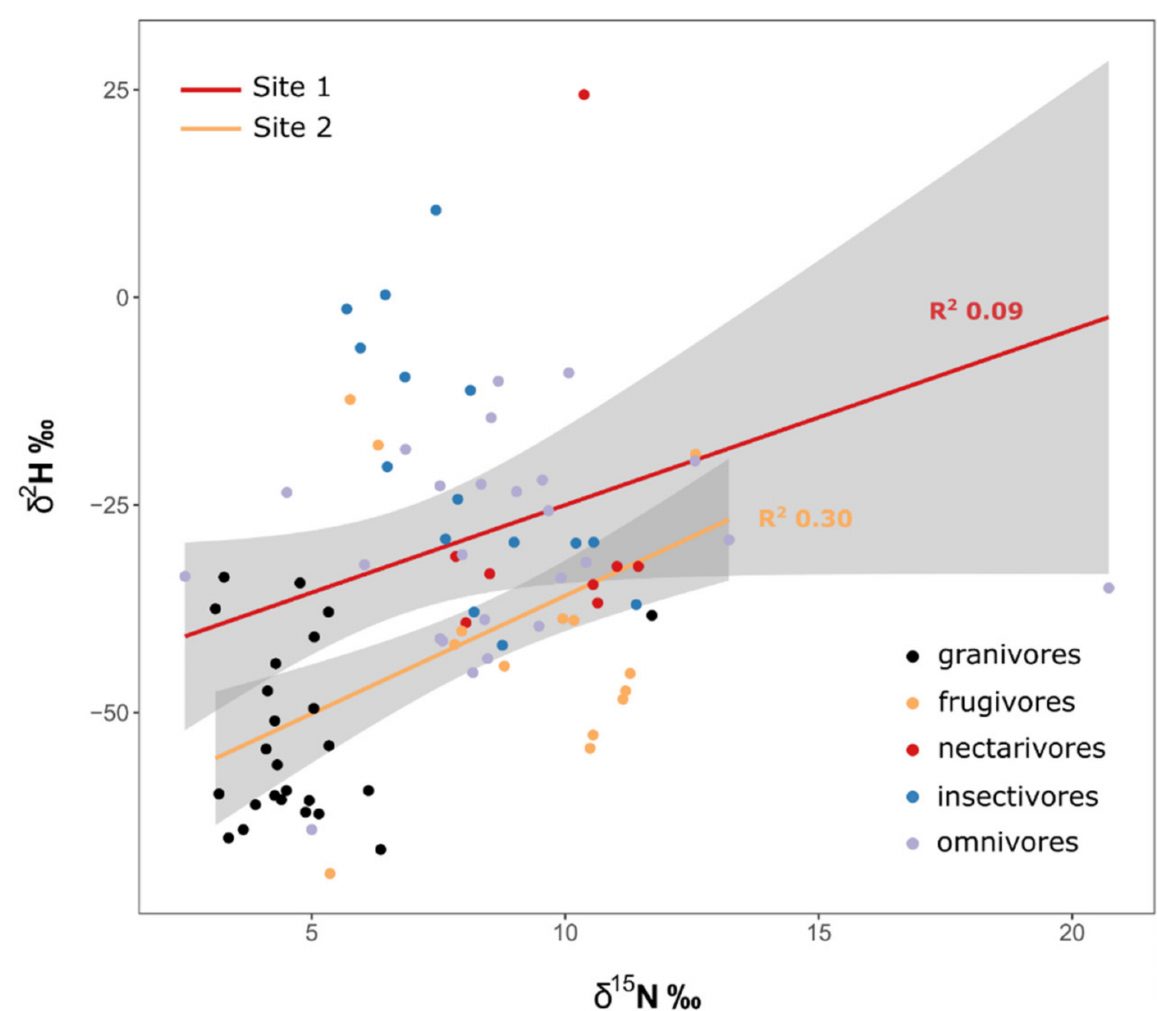
Figure 2. Regression between δ 2 H vs. δ 15 N by site, with colors representing different guilds. Regression lines are indicated in shaded grey, with the 95% confidence band of the regression estimate and its corresponding R 2